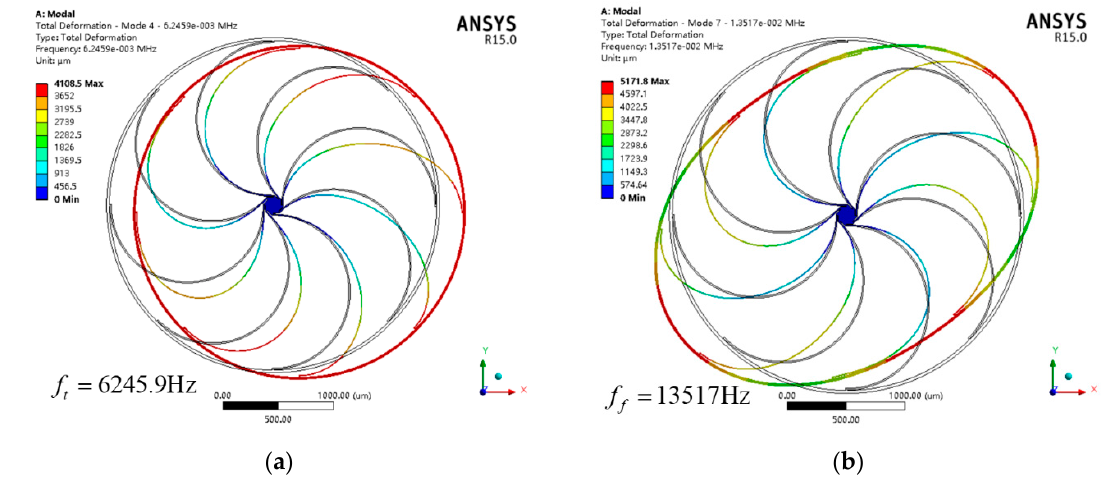
Figure 2. Modal analysis of the translation mode ( a ) and flexural mode ( b ) of a typical vibrating ring